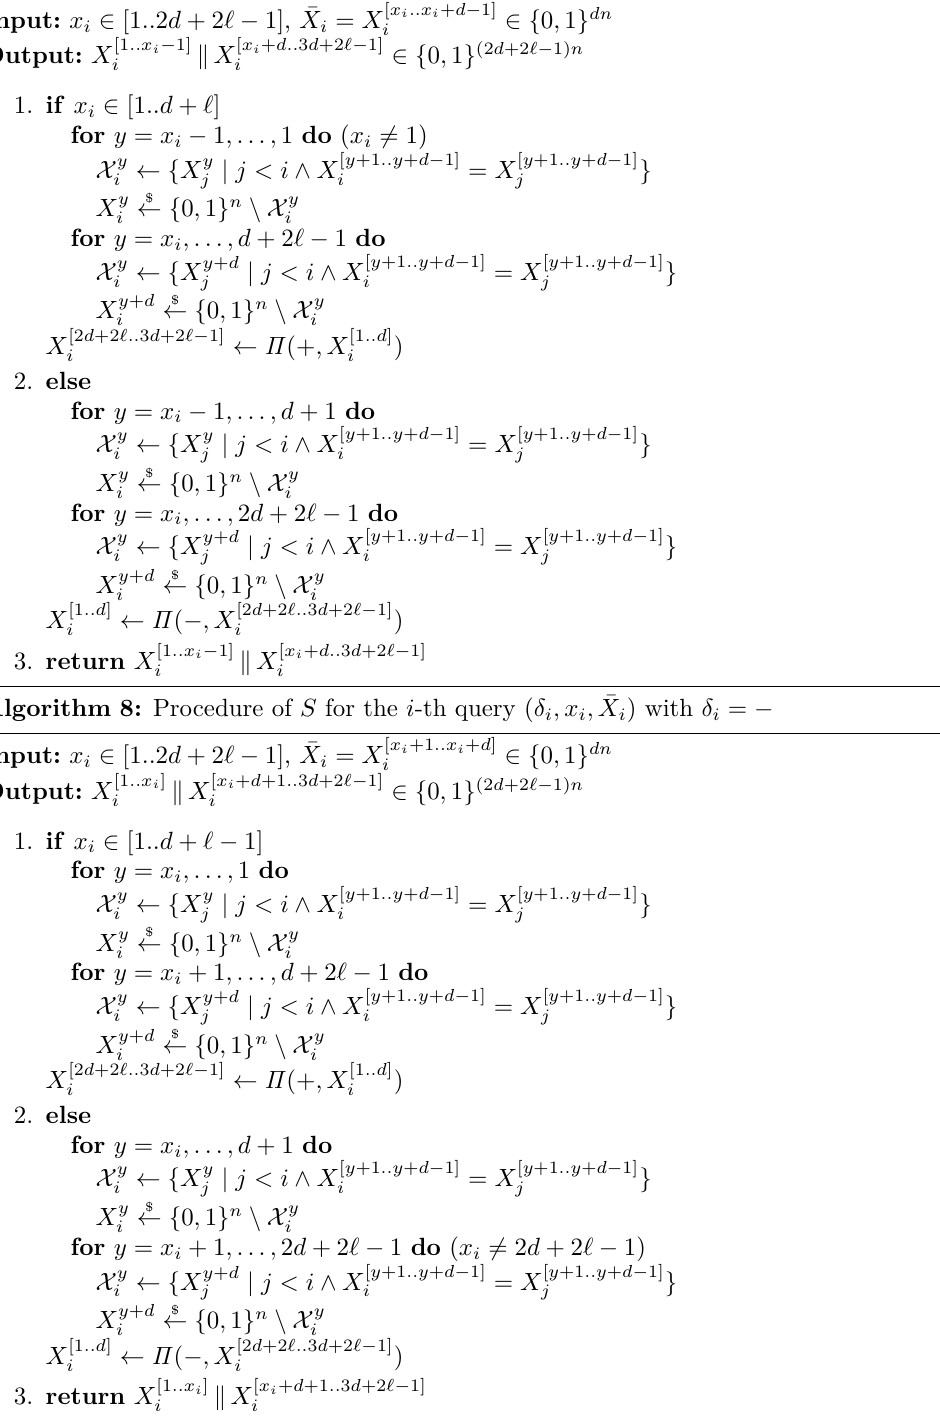
¯ X i , x i , i ) with δ i = +